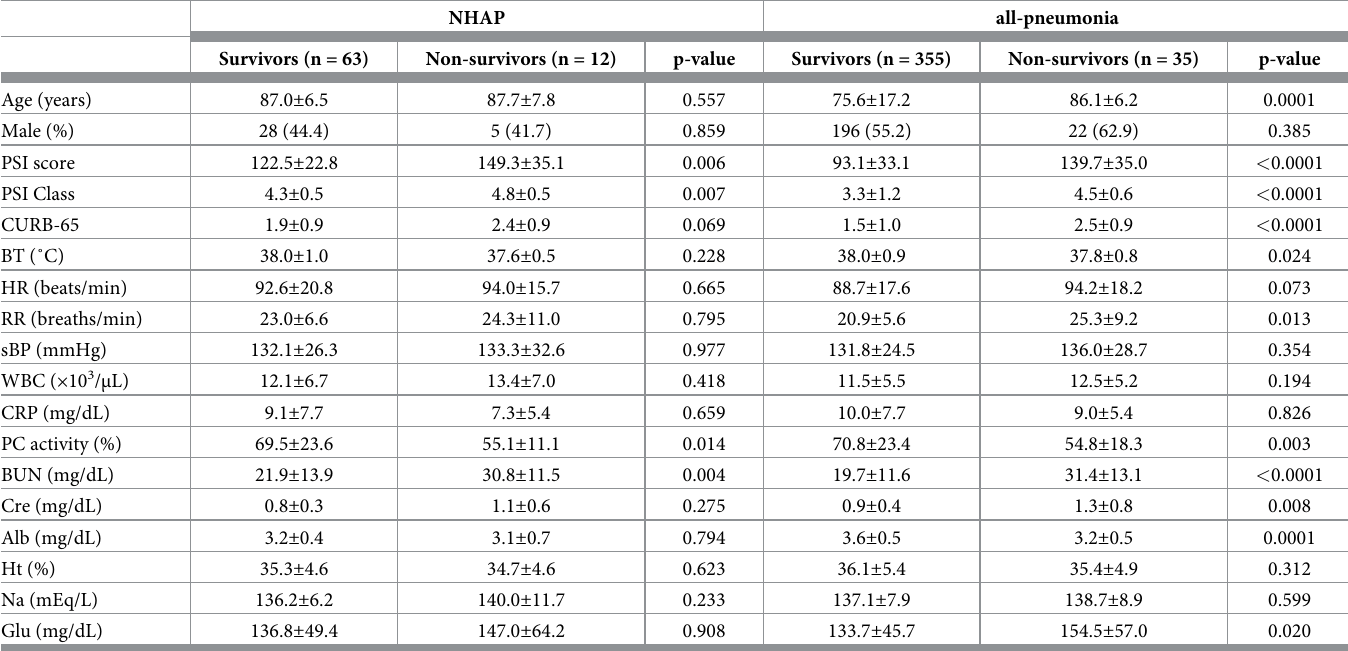
Table 3. Comparison between survivors and non-survivors in NHAP and all-pneumonia.